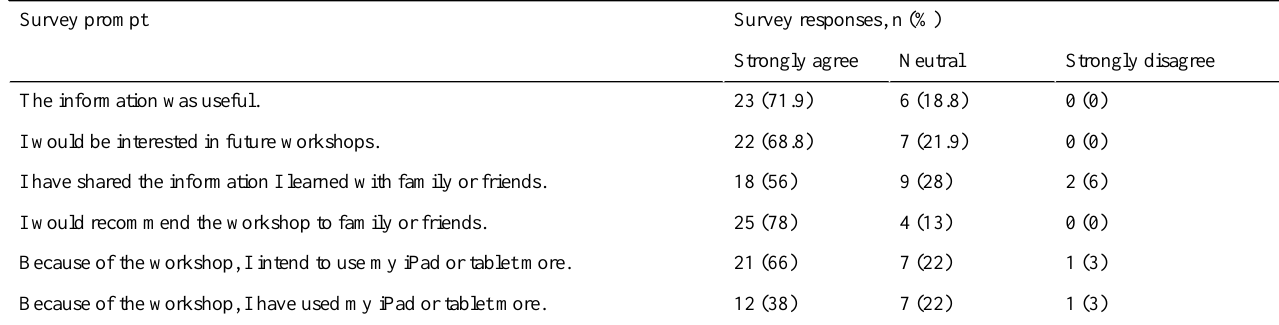
Table 4. Participant satisfaction with the AGE-ON